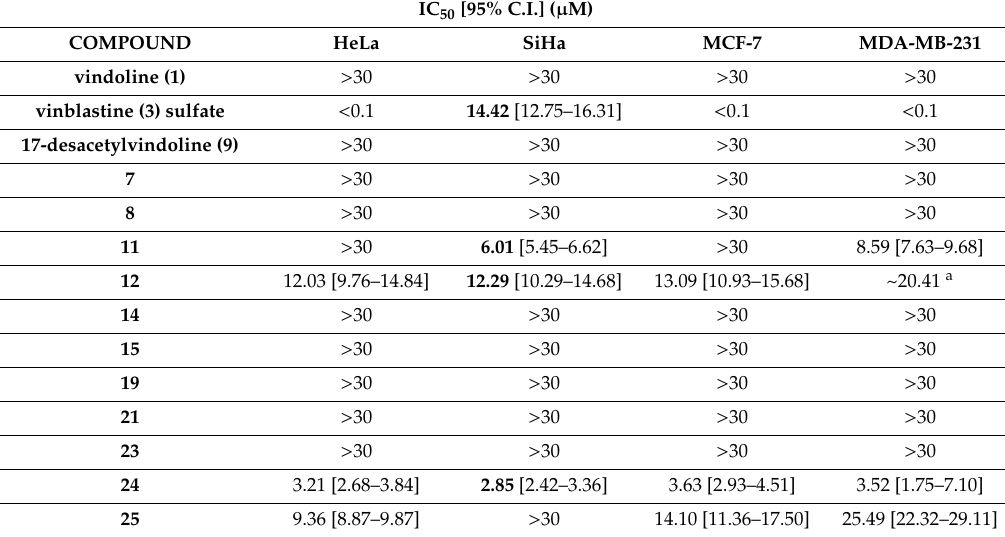
Table 1. In vitro antiproliferative activity of selected compounds against human gynecological cancer cell lines. Compounds were tested in the concentration range of 0.1–30 µ M in 2 biological replicates, 5 parallel measurements each. IC 50 values and their 95% confidence intervals (C.I.) are presented. Bold font of numbers mean stronger IC 50 values compared to vinblastine ( 3 ) sulfate on SiHa cells. IC 50 [95% C.I.] ( µ